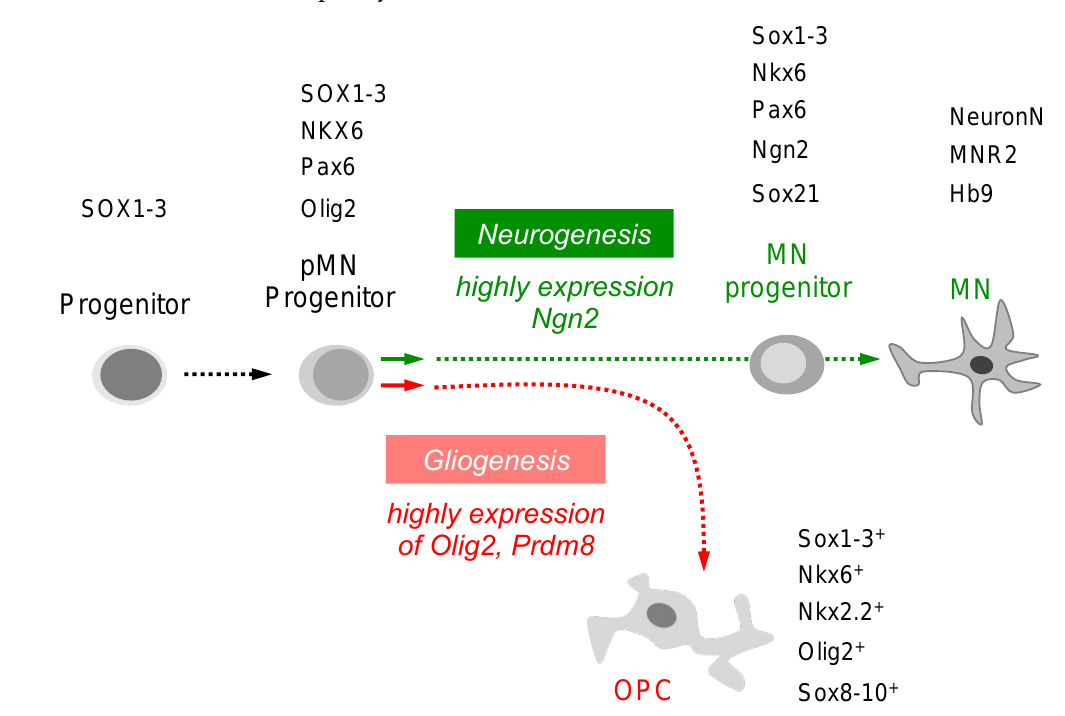
Figure 2. A graphic is displayed to depict the intrinsic signaling pathway through which various transcription factors can induce pMN progenitors to differentiate into distinct cell types. The specification of pluripotent stem cells and neural precursor cells is mediated by transcription factors. Neurogenesis is promoted by a high level of Ngn2, leading to the differentiation of pMN progenitors into mature motor neurons, while gliogenesis is facilitated by a high level of Olig2 or Prdm8, resulting in the differentiation of pMN progenitors into OPCs.